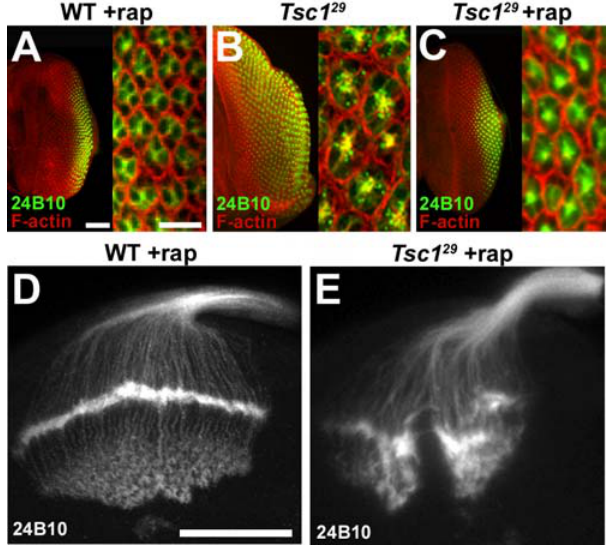
Figure 7. Axon guidance defects in Tsc1mosaics are not suppressed by blocking growth. (A–C) Third instar eye discs from wild type and Tsc1 mosaic larvae raised with or without rapamycin (rap). Ommatidial units, comprised of eight photoreceptors, were visualized with phalloidin (red) that detects F-actin, and MAb24B10 (green). Phalloidin staining is strongest at the perimeter of each ommatidium, outlining each sensory unit. Rapamycin treatment of Tsc1 mosaic eye discs (C) restored eye disk size and cell size compared to wild type (A). (D and E) Rapamycin treated third instar larval brains stained with MAb24B10. Rapamycin treatment blocked abnormal growth of the retina and the increase in photoreceptor cell size, but did not ameliorate the abnormal axon projections also characteristic to untreated Tsc1 29 mosaics. The scale bars in panel A represent 50 microns in the left image, 10 microns in the right image. The scale bar is 50 microns in panel